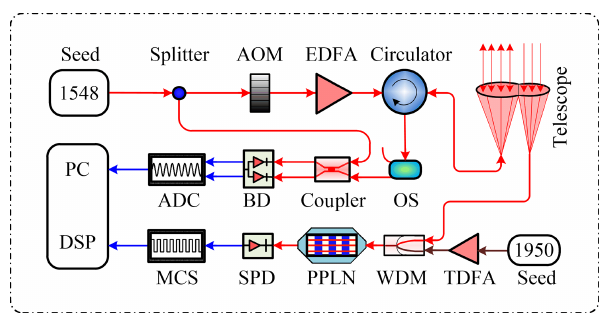
Figure 1. The diagram of the integrated lidar